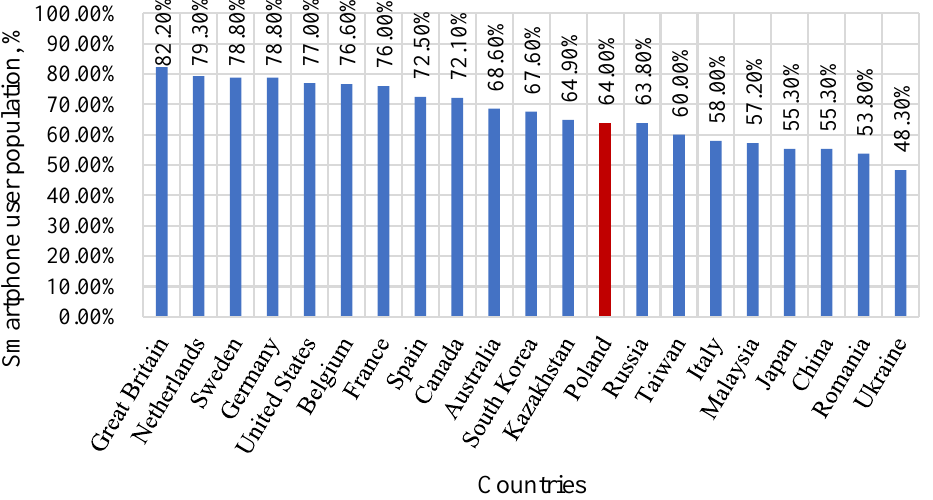
Figure 1. Characteristics of smartphone penetration in selected countries .